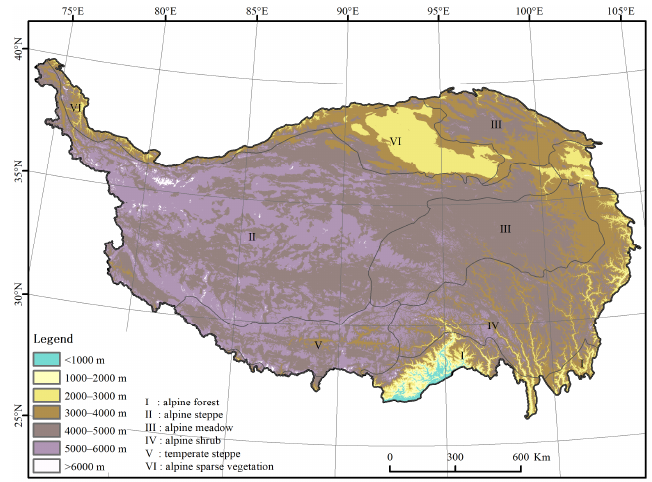
Figure 1. Digital elevation models and vegetation zone of the QTP; the vegetation zone data was extracted from Chinese vegetation zone data (downloaded from the Resource and Environment Science and Data Center, https://www.resdc.cn/data.aspx?DATAID=133, accessed on 18 October 2021).